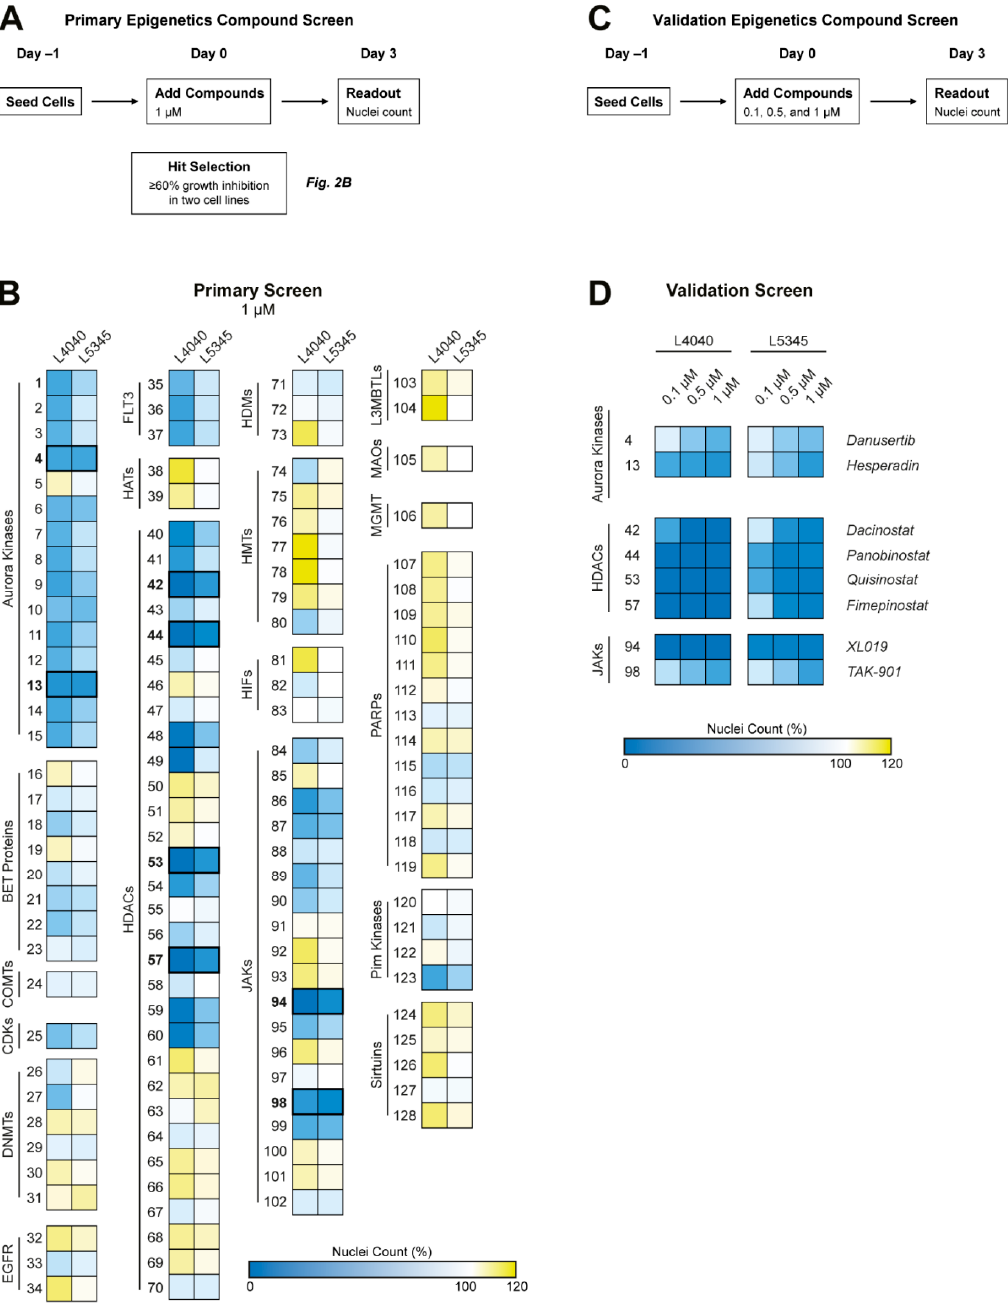
Figure 2. Epigenetics compound screen identified Aurora kinases, Janus kinases, and HDAC enzymes as potential therapeutic targets for GCTB. ( A ) Schematic overview of the performed primary epigenetics compound screen. ( B ) Two cell lines were treated with 128 compounds for 72 h at a concentration of 1 µM. Numbers correspond to compounds presented in Table S3. Heatmap colors indicate growth inhibition (blue), similar growth (white), or growth induction (yellow) as compared with the 0.1% DMSO-treated control wells. Aurora kinase, HDAC, and JAK inhibitors were identified as compound classes of interest. Compounds that inhibited growth with ≥ 60% in both cell lines were selected for a validation screen, as indicated by the bold numbers and lines ( n = 8). ( C ) Schematic overview of the performed validation epigenetics compound screen. ( D ) Both cell lines were treated with the eight selected compounds for 72 h at three different concentrations (i.e., 0.1, 0.5, and 1 µ M). Heatmap colors are equal to ( A ). All HDAC inhibitors and one JAK inhibitor (i.e., XL019) had a pronounced effect on cellular growth at the lowest compound